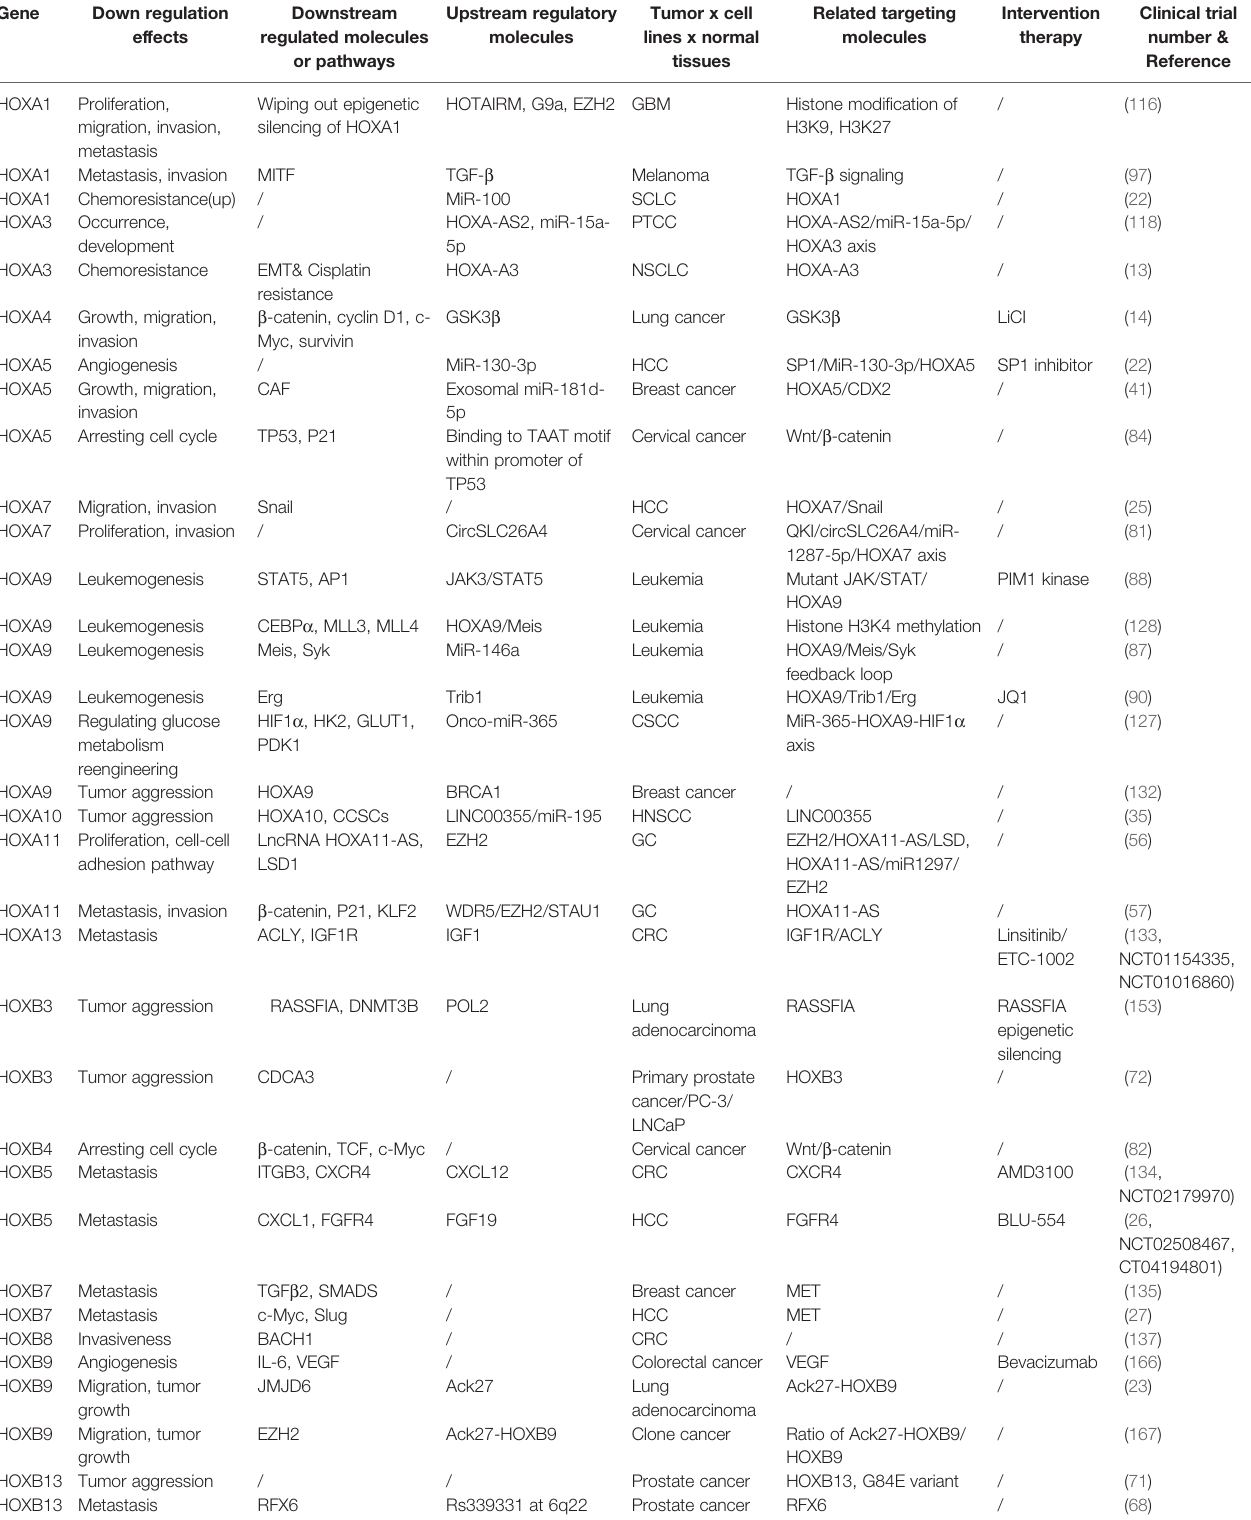
TABLE 2 | Therapeutic values of HOX factors in human cancer.